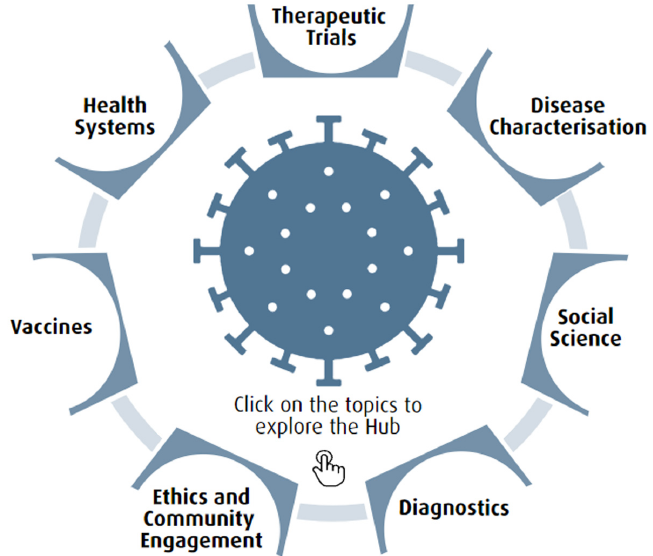
Figure 1. The COVID Research Implementation Hub: Infographic used to direct research team to protocols, tools, training and guidance during the coronavirus disease 2019 (COVID-19) pandemic across all the different types of studies that were